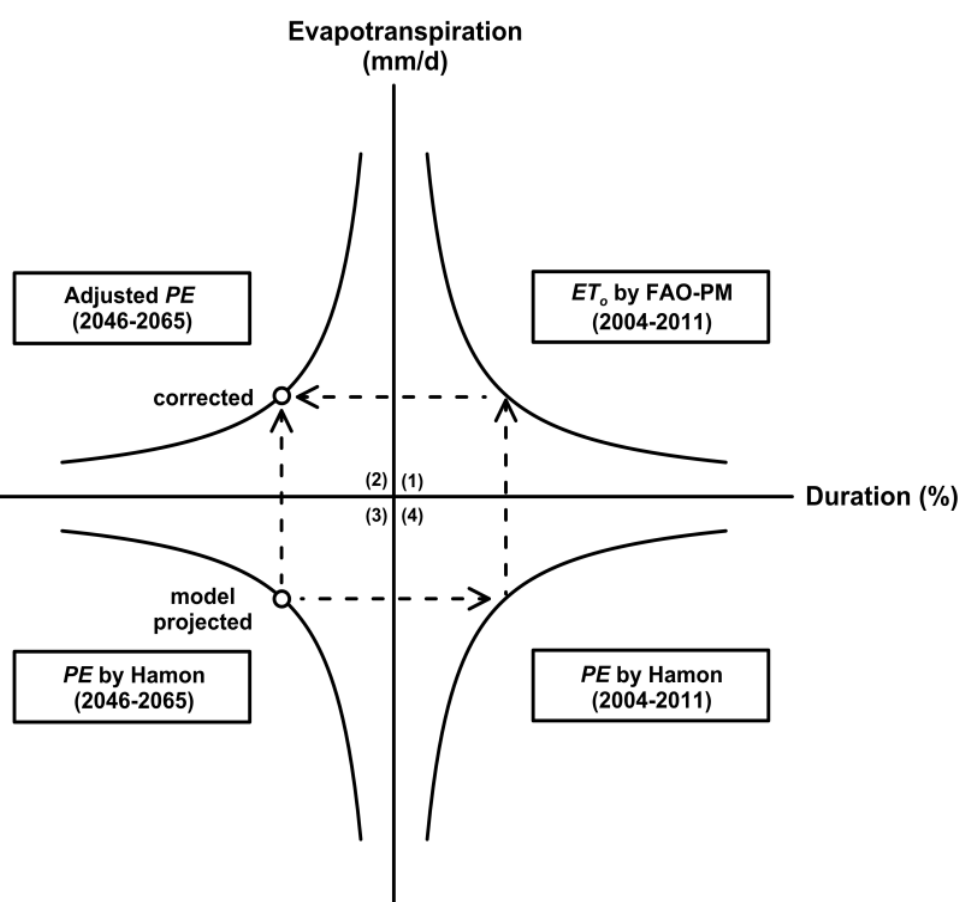
Figure 4. Bias correction of evapotranspiration through quadrant